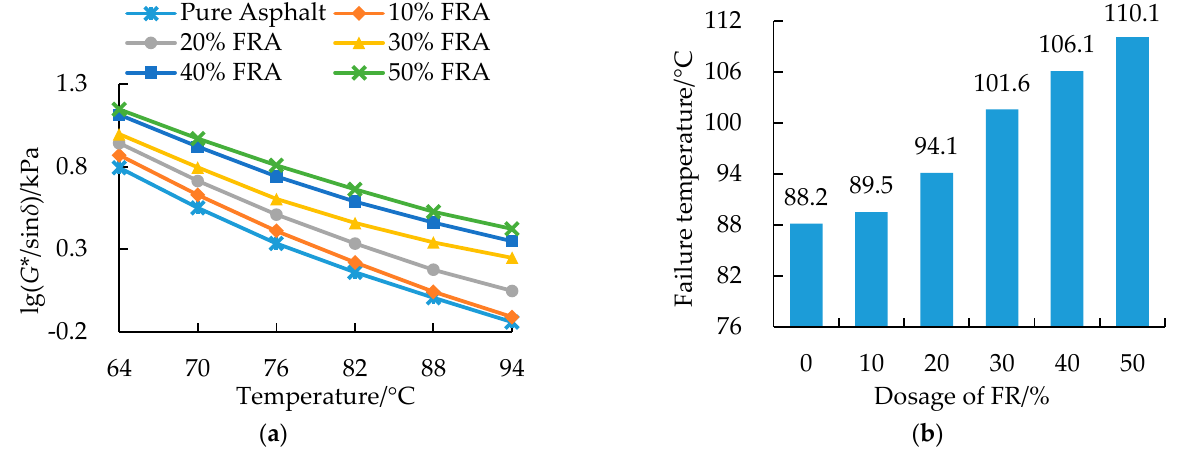
Figure 9. Rutting parameter and critical failure temperature for pure asphalt binder and FRA: ( a ) rutting parameter; ( b ) failure temperature.